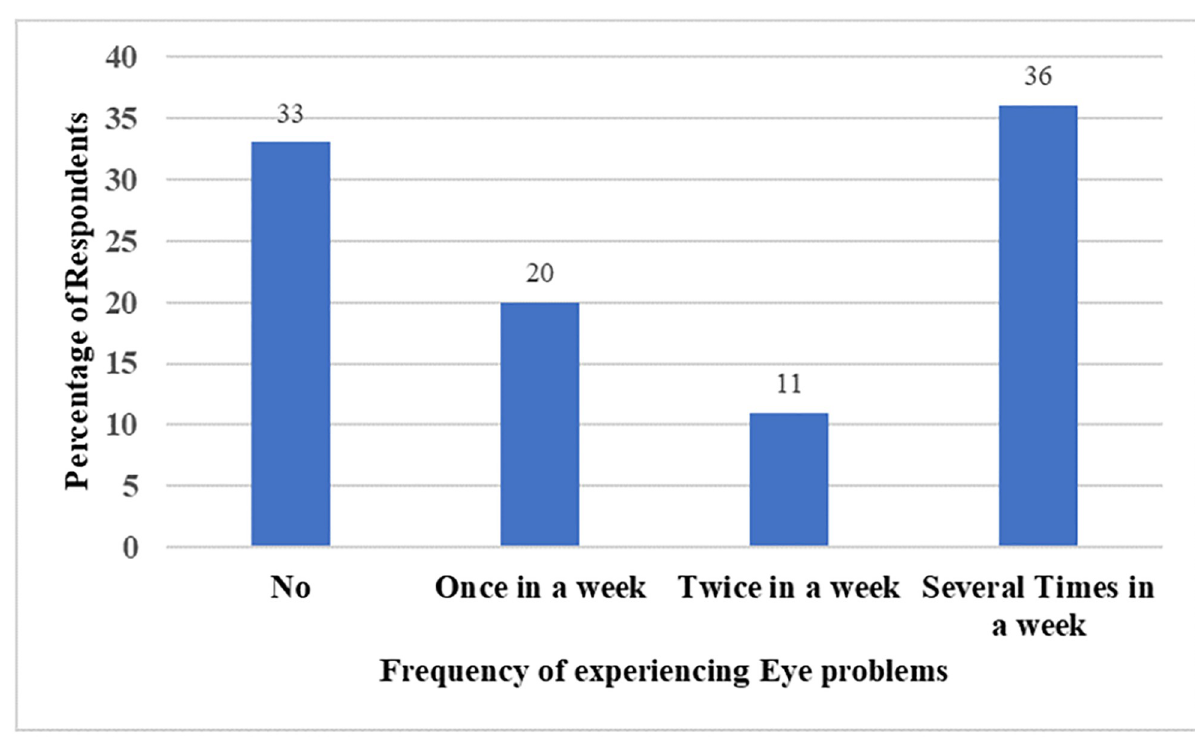
Fig 4. Association between fish smoking and eye irritation or infection.